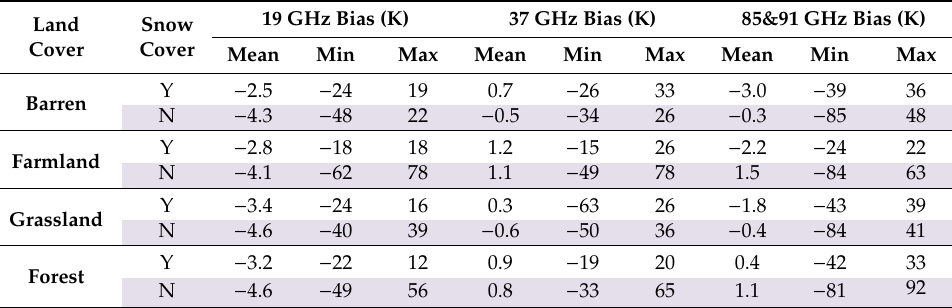
Table 5. Summary of bias between SSM / I and SSMIS at di ff erent land cover.